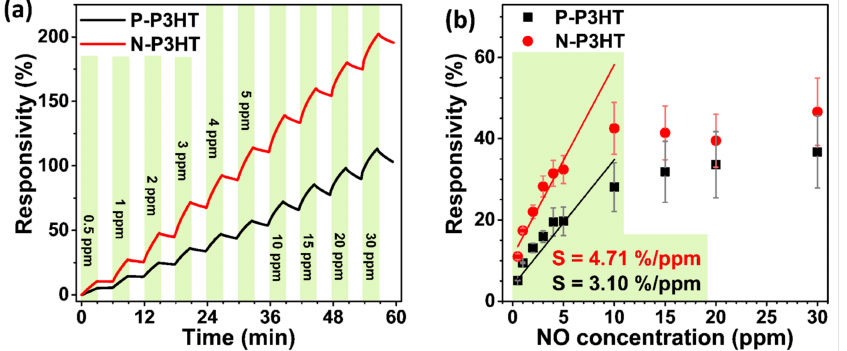
Figure 5. ( a ) Real-time responsivity and ( b ) responsivity vs. NO concentration plots of the P-P3HT and N-P3HT OFET sensors. Table 2. Responsivity (%) of the P-P3HT-based and N-P3HT-based OFET sensors to various NO gas